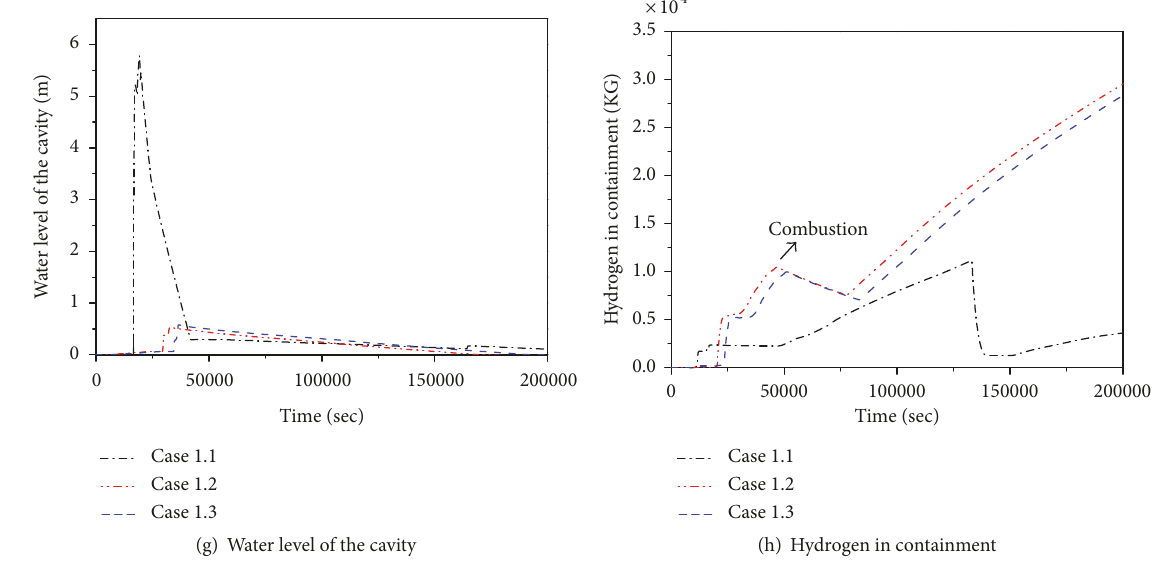
Figure 7: Effect of intentional depressurization